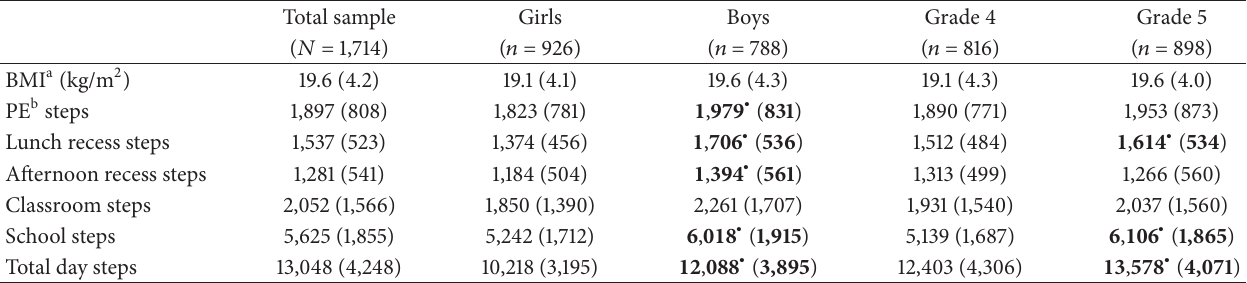
Table 1: Descriptive statistics for the total sample and within sex and grade groups (means and standard deviations).